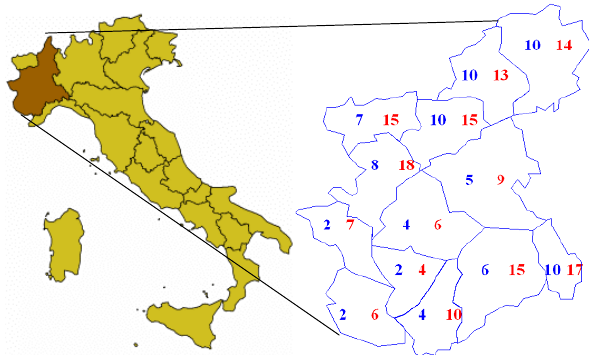
Fig. 1 . Example of data observed in Piemonte region (north-western Italy) on May 23, 2007. Fig. 1. Example of data observed in Piemonte region (north-western Blue numbers represent the observed (or forecasted) 6-hours precipitation (mm) averaged Italy) on 23 May 2007. Blue numbers represent the observed (or over the catchment, while red numbers are the maximum precipitation observed (or forecasted) 6-h precipitation (mm) averaged over the catchment, forecasted) in the catchment. while red numbers are the maximum precipitation observed (or forecasted) in the catchment.